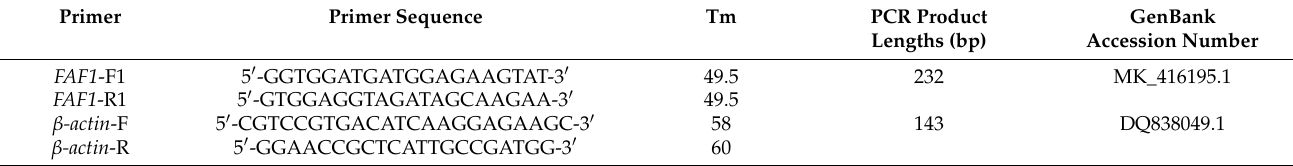
Table 1. Primer sequences and lengths. T m —melting